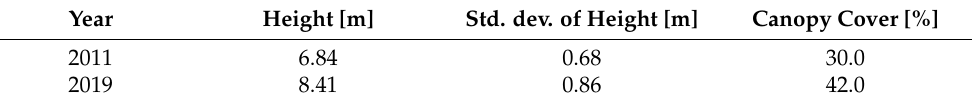
Table 1. LiDAR metrics for vegetation—mean values of height, std. dev. of height, canopy cover. Height Std. dev. of Height Year [m]